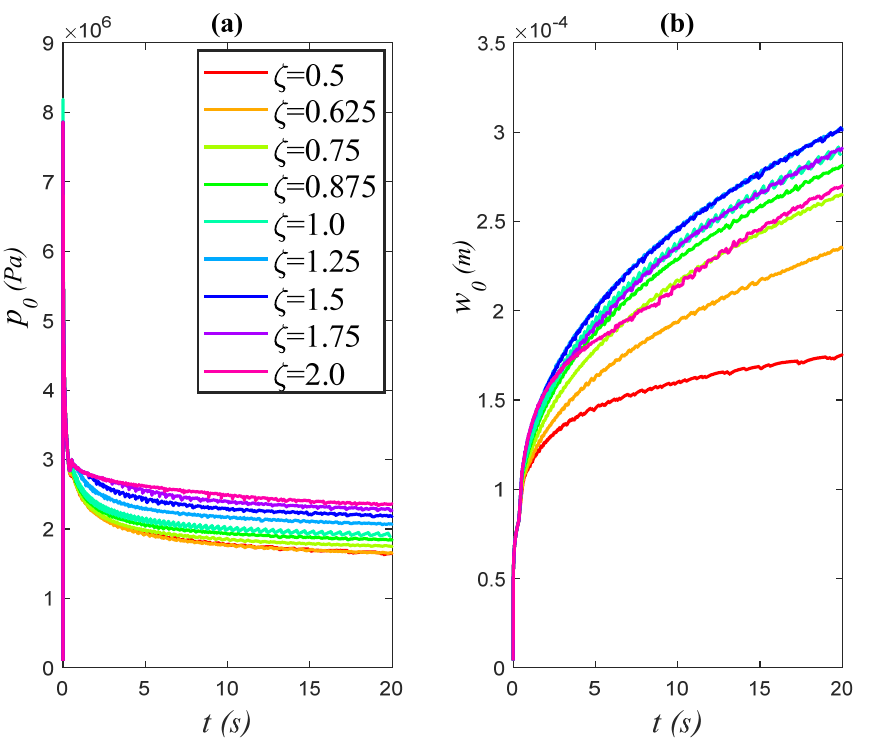
Figure 23. Evolution of the fluid pressure p 0 and the fracture opening w 0 at the wellbore under the proportion of pay zone ξ = 3/9.